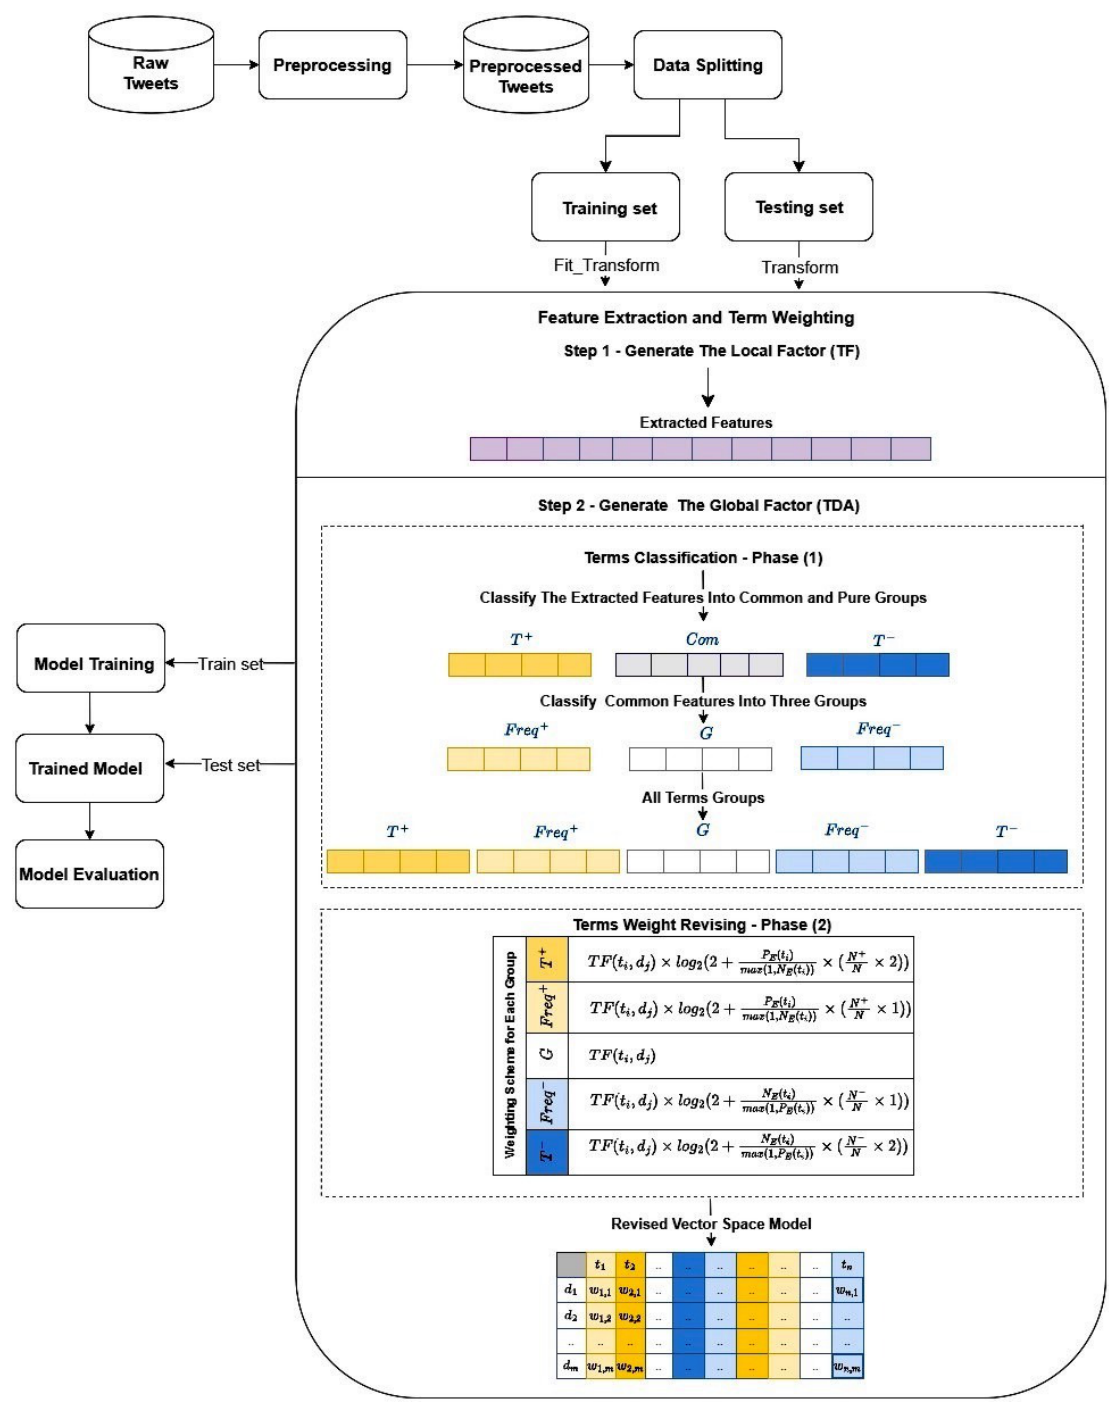
Figure 2. The architecture of the TF-TDA